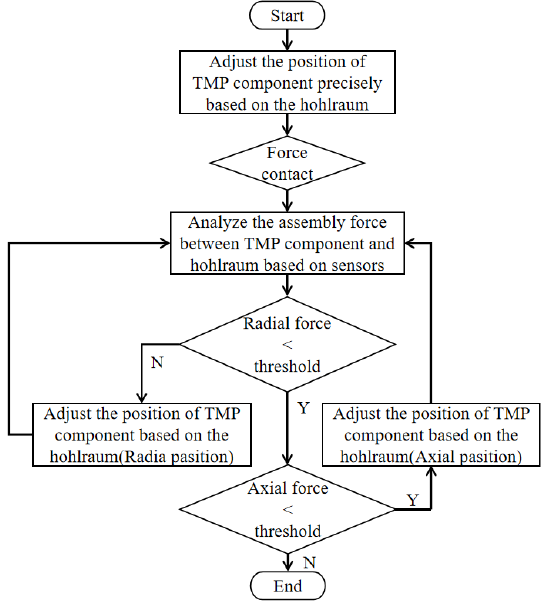
Figure 10. Flowchart of adjustment based on assembly force.